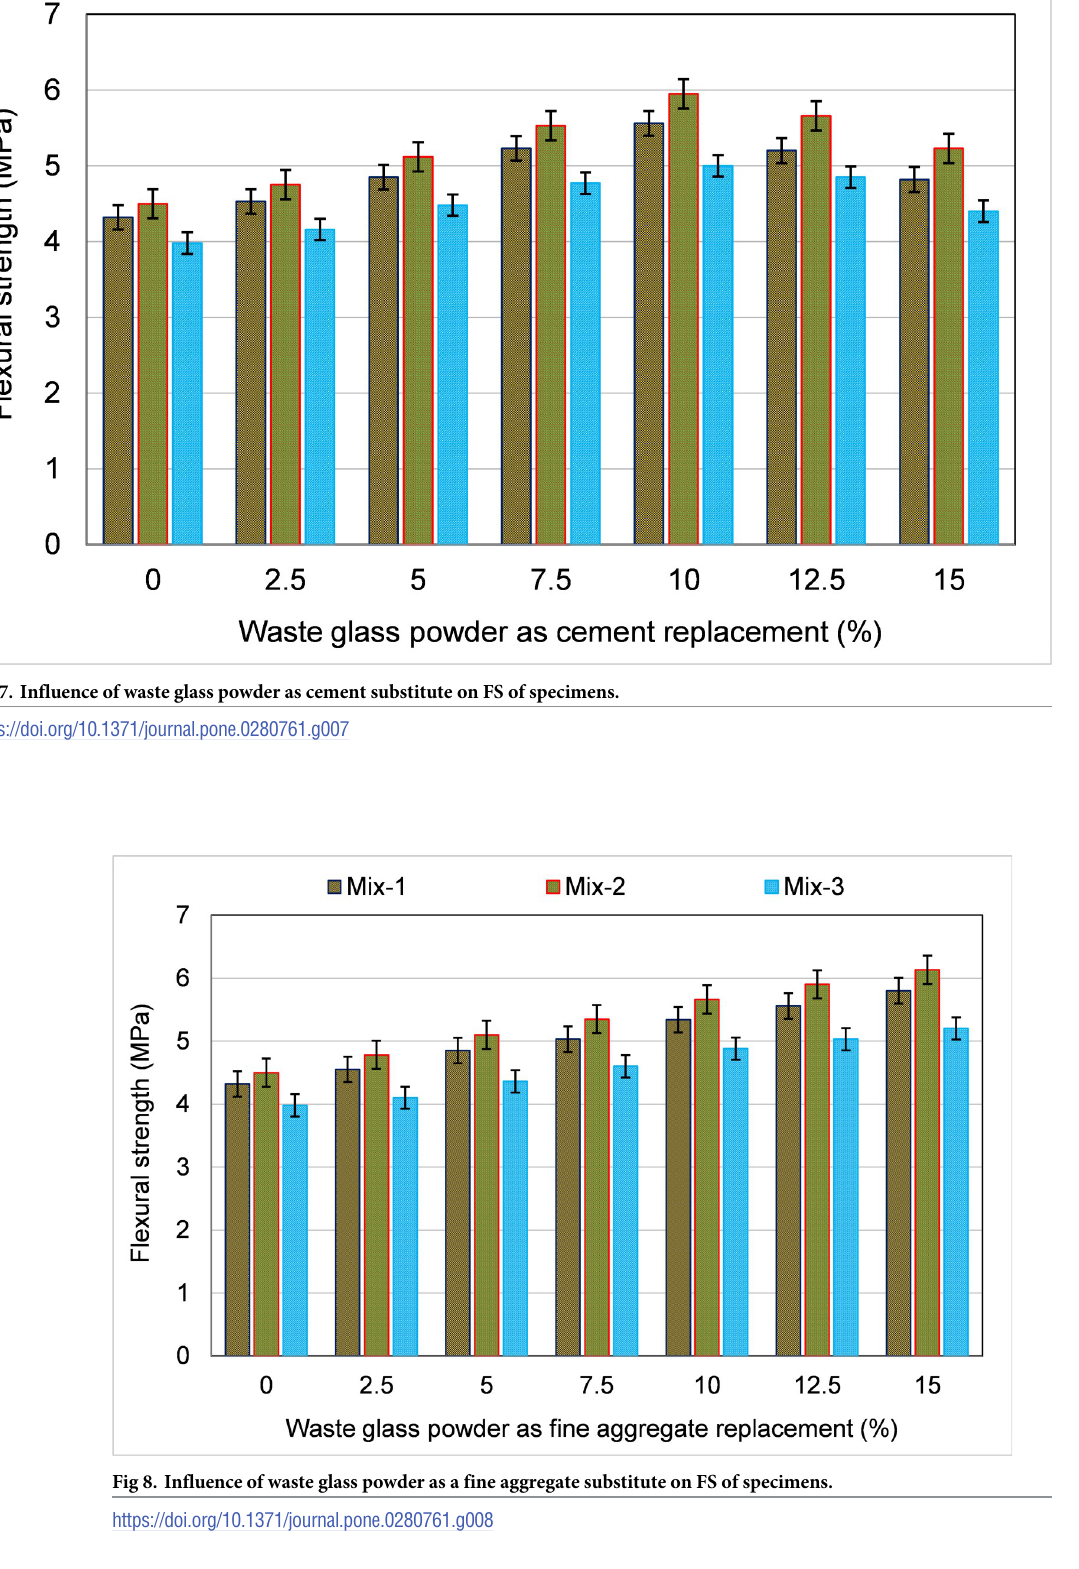
PLOS ONE | https://doi.org/10.1371/journal.pone.0280761 January 23,